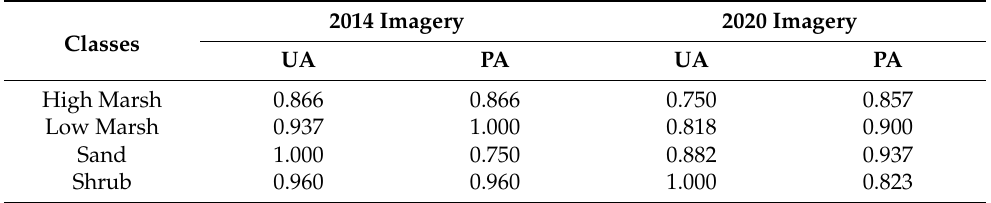
and PA = Producer’s Accuracy.